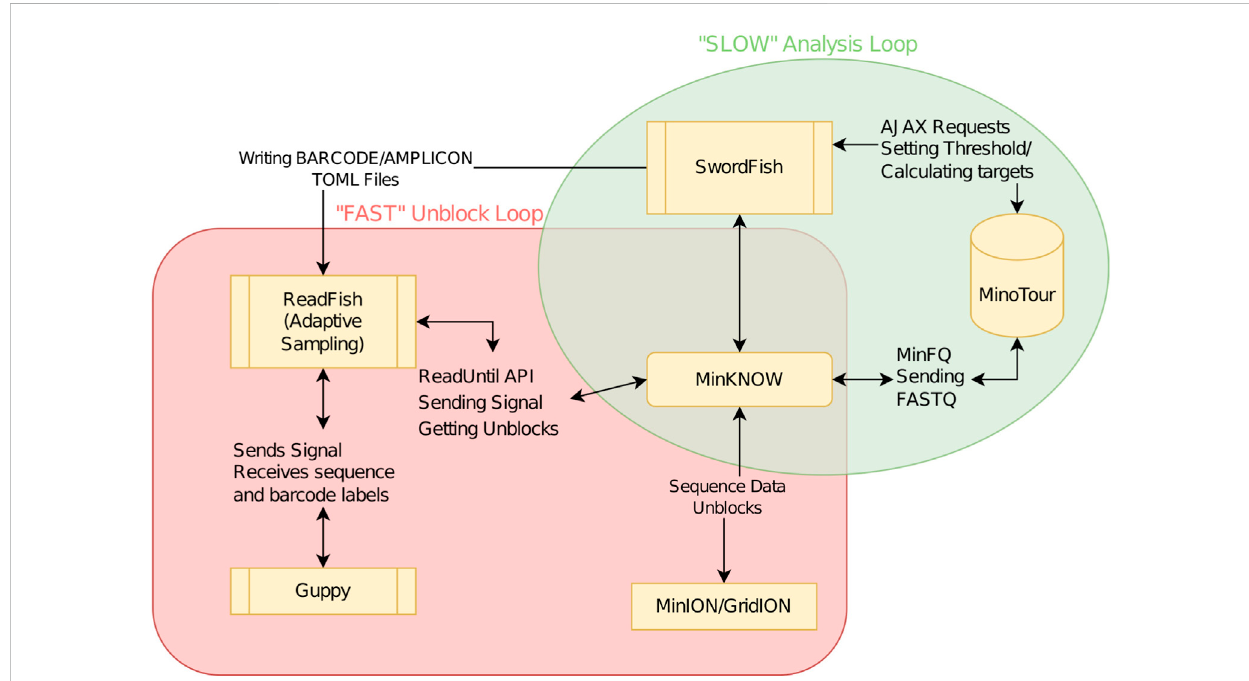
FIGURE 1 Flowchart demonstrating ReadFish/SwordFish/minoTour interactions. The slow analysis loop (green) is used to update ReadFish ’ s target TOML fi le. The loop is run once every 60 s. MinFQ uploads FASTQ sequence data to minoTour, which tracks coverage for each amplicon on each barcode. SwordFish queries minoTour for the set of amplicon coordinates on each barcode to unblock. These are de fi ned as those exceeding a speci fi ed level of coverage (e.g., 50×). SwordFish updates a TOML fi le that can be read by ReadFish. The fast analysis loop (red) is run every read batch (approximately 0.8 s). ReadFish updates its coordinates from the TOML fi le, base calls and demultiplexes all reads in the batch using Guppy, and then sends unblock signals to MinKNOW for any reads that align inside any amplicon with suf fi cient